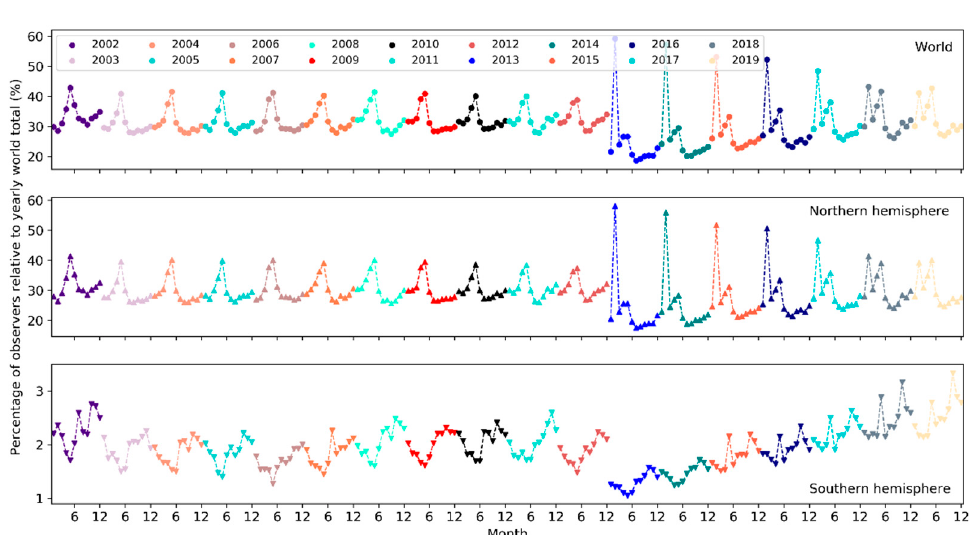
Figure 11. Percentage of observers in each month relative to the yearly total number of observers.